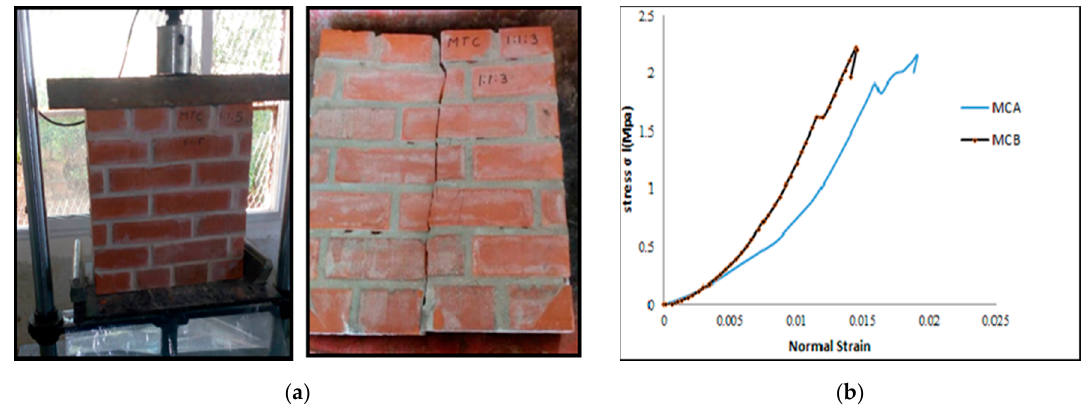
Figure 4. ( a ) Failure modes; ( b ) stress-strain responses of masonry panels (MCA, MCB).